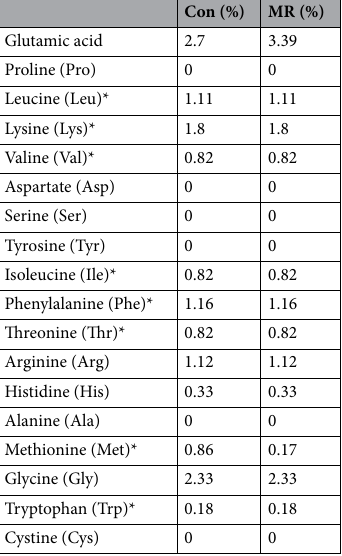
Table 2. Dietary amino acid composition. *Indicates essential amino